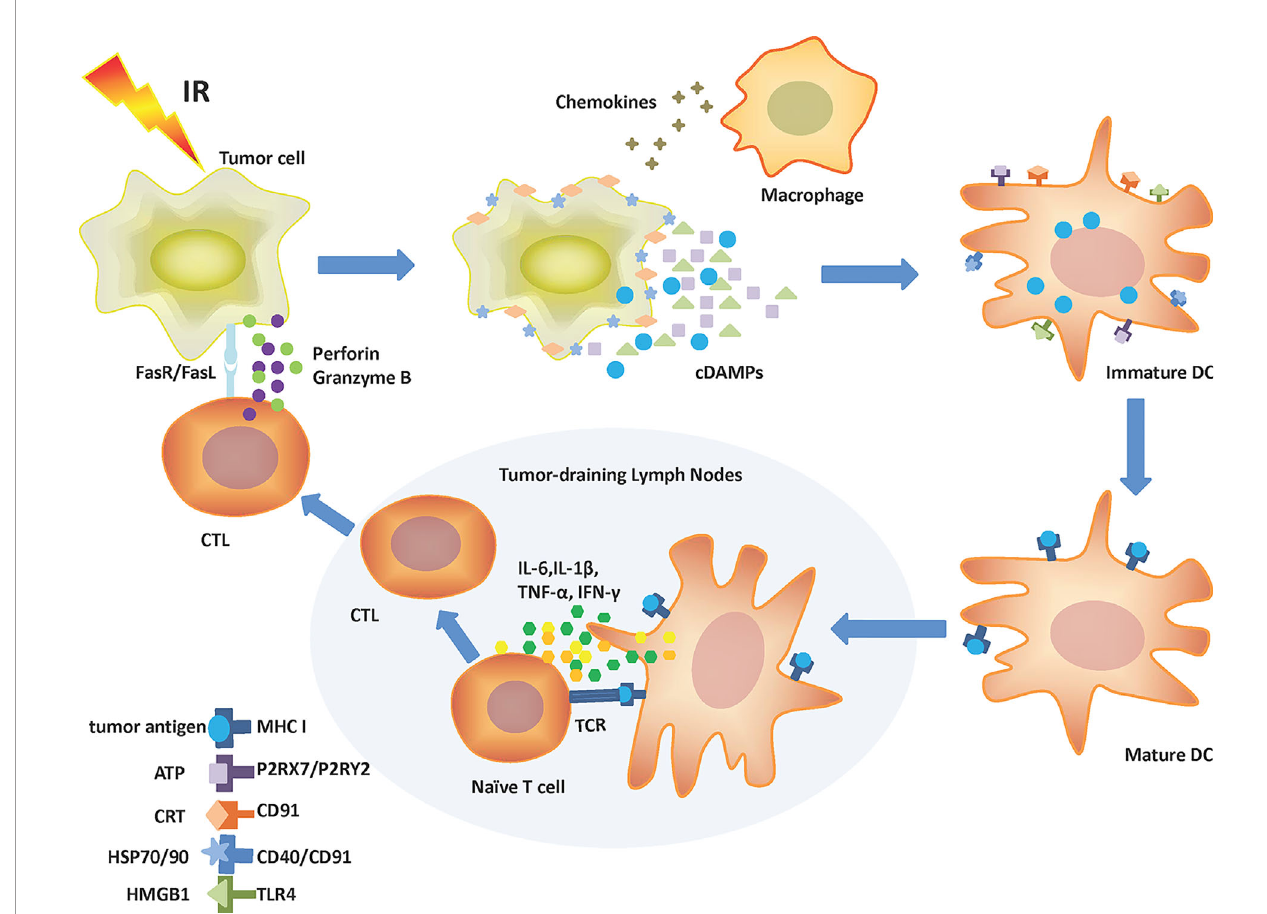
FIGURE 1 | Mechanism of IR-driven ICD. Tumor cells release cDAMPs, chemokines, and tumor antigens following IR. Chemokines attract macrophages and immature DCs to tumor cells. cDAMPs like ATP, CRT, HSP70/90, and HMGB1 bind to corresponding receptors (P2RX7/P2RY2, CD91, CD40/CD91, and TLR4, respectively) on DCs leading to their activation. Recruited DCs can engulf and process tumor antigens. Mature DCs present tumor antigens to surface MHC-I molecules and then migrate to tumor-draining lymph nodes. There, DCs produce IL-6, IL-1 b , TNF- a , and IFN- g and cross-present antigens to boost T-cell differentiation to CTLs. CTLs can migrate to the tumor site and kill malignant cells by releasing perforin, granzyme B, or through the stimulation of the Fas/FasL pathway. ATP, Adenosine triphosphate; cDAMPs, Constitutive damage-associated molecular patterns; CRT, Calreticulin; CTL, Cytotoxic T lymphocyte; DC, Dendritic cell; Fas, Factor-related apoptosis; FasL, Factor-related apoptosis ligand; HMGB1, High mobility group box 1; HSP, Heat shock protein; ICD, Immunogenic cell death; IFN- g , Type g interferon; IL-1 b , Interleukin-1 b ; IL-6, Interleukin-6; IR, Ionizing radiation; MHC I, Major histocompatibility complex class I; P2RX7, P2X purinoceptor 7; P2RY2, Purinergic receptor P2Y2; TCR, T-cell receptor; TLR4, Toll-like receptor 4; TNF- a , Tumor necrosis factor- a